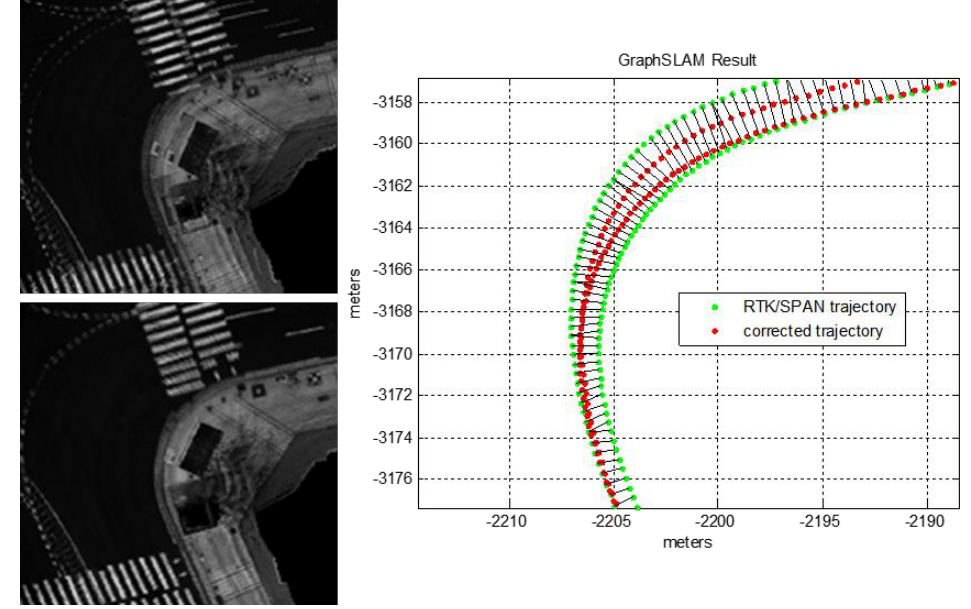
Figure 5. Graph optimization result of vehicle trajectory using GraphSLAM.